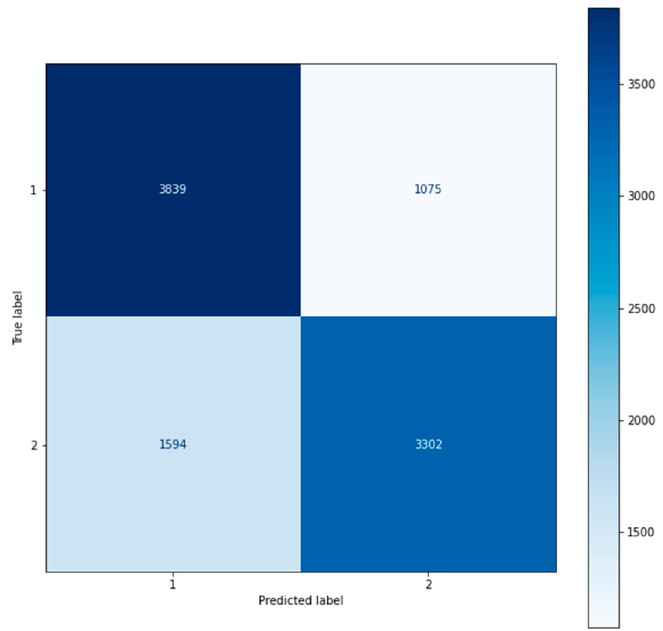
Figure 12. The confusion matrix for change identity classifier.